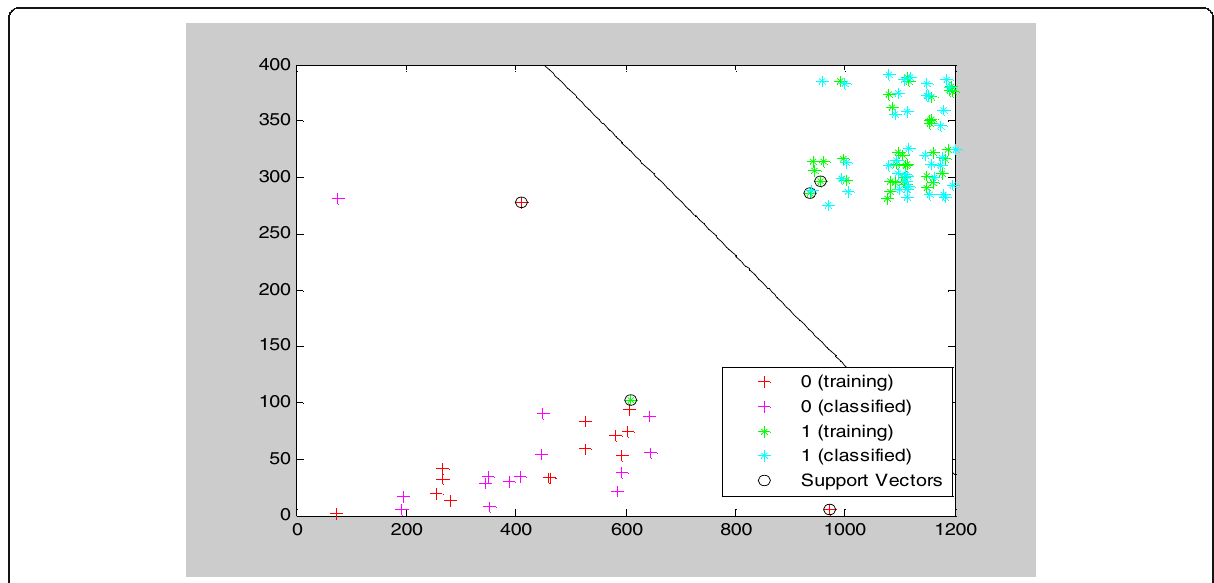
Fig. 6 SVM classification for array